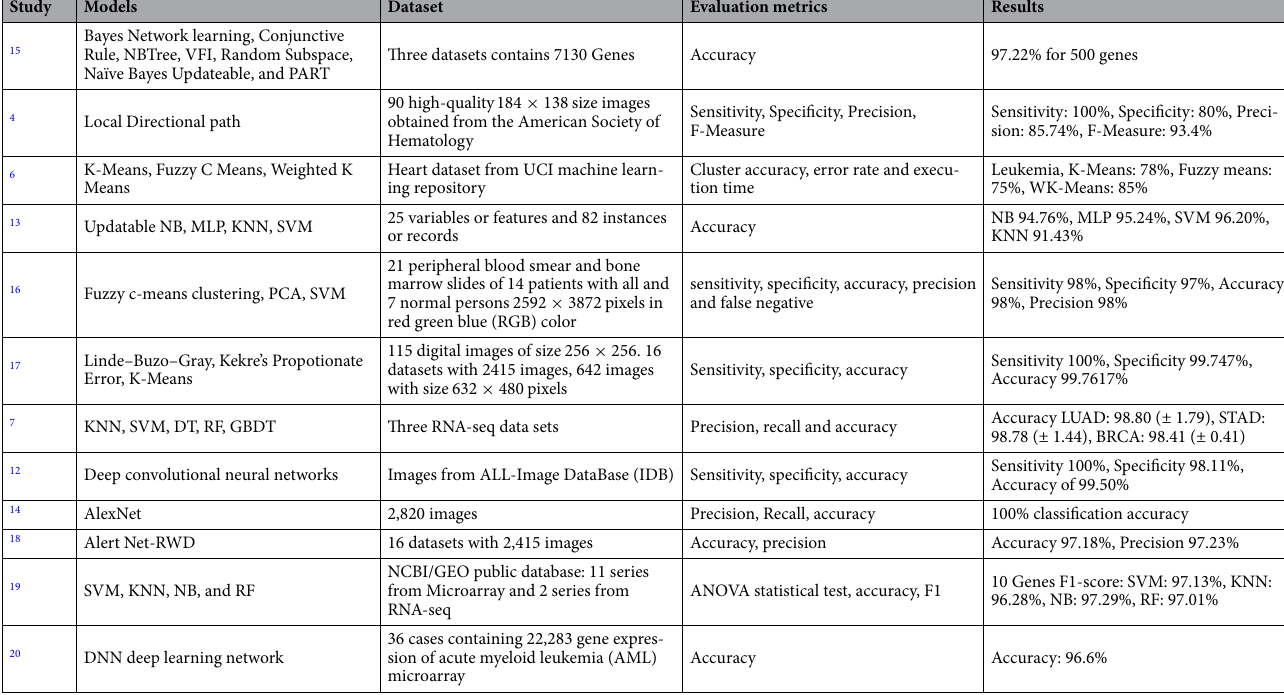
Table 1. Summary of the systematic analysis studies in related